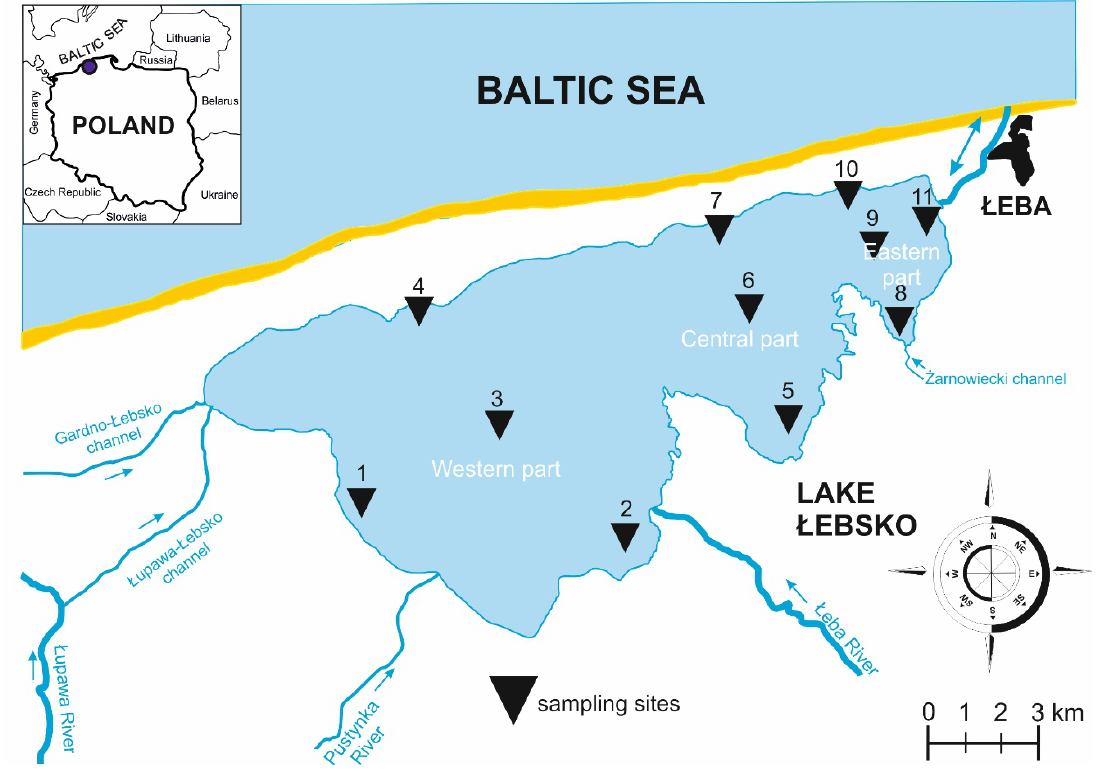
Figure 1. Map of sampling sites of Lake Łebsko, Poland, in 2014 – 2015.